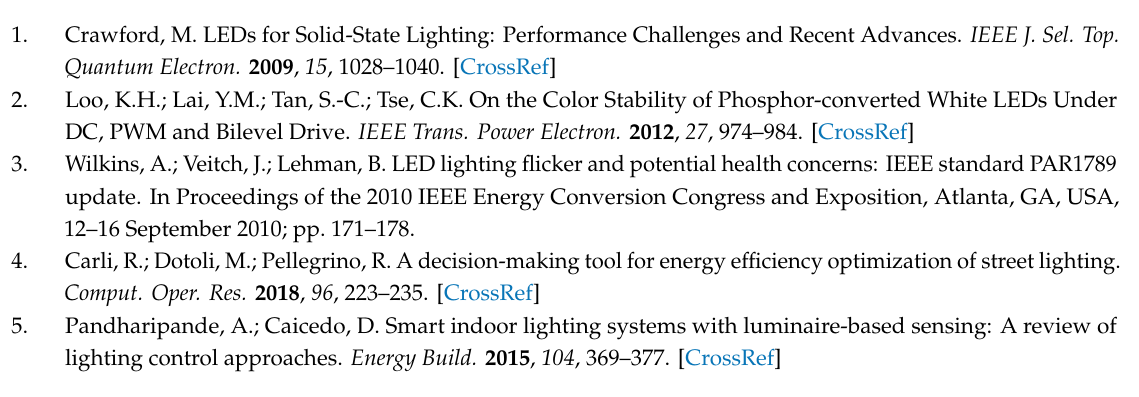
Figure 18. Bi-level modulation of the lamp current for implementing data transmission at 10 kB/s.